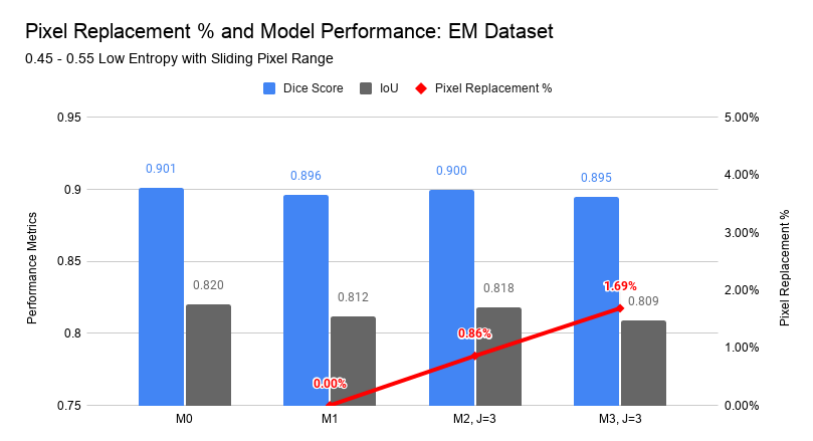
Figure 4. Performance on the EM dataset using the SSPA approach with LE pixel label